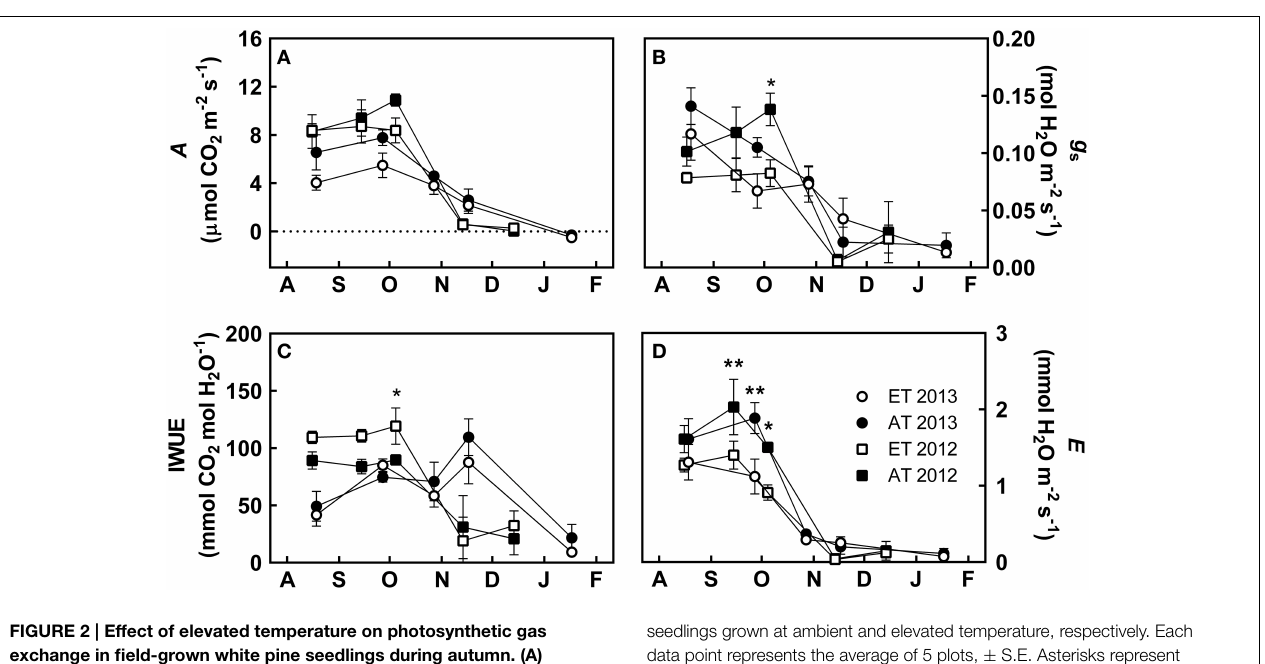
seedlings grown at ambient and elevated temperature, respectively. Each data point represents the average of 5 plots, ± S.E. Asterisks represent significant treatment effect at a single measuring date ( ∗∗ P < 0 . 01 , ∗ P < 0 . 05 ).